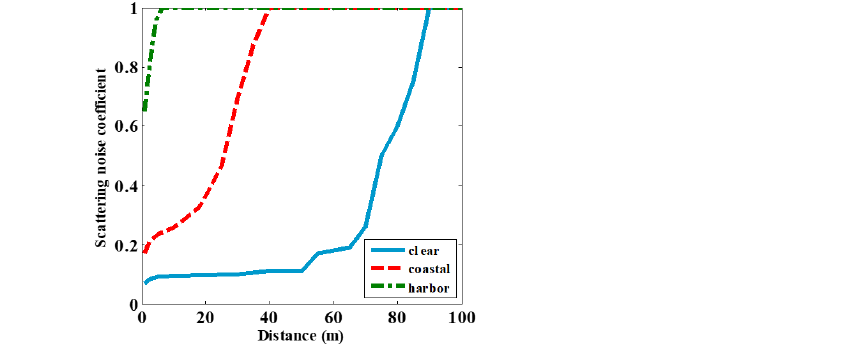
Figure 3. The scattering noise coefficient( κ ) against the link distance for clear, coastal and harbor